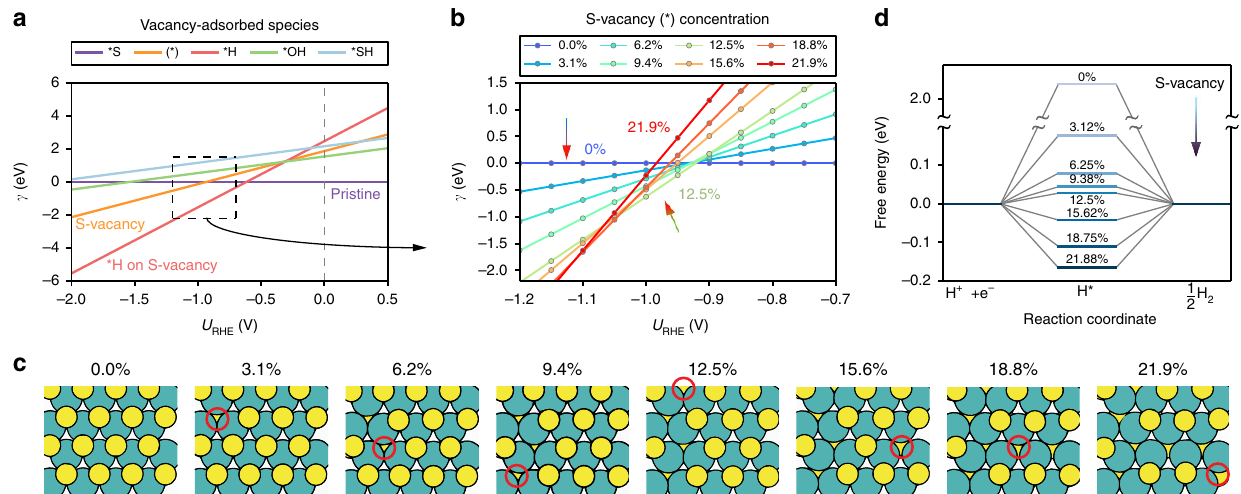
Figure 1 | Theoretical predictions. ( a ) Surface energy per unit cell for 2 H -MoS 2 as a function of applied potential for the basal plane of 2 H -MoS 2 with different adsorbate species at a fixed sulfur vacancy (3.1%). The surface energies of various species in the S-vacancy are shown. (*) Refers to a S-vacancy and the adsorbed species in the S-vacancy are denoted by *prefix. *S refers to sulfur adsorbed in the vacancy, that is, a pristine basal plane without S-vacancies. ( b ) Surface energy per unit cell for a range of S-vacancy concentrations, without any adsorbates. The concentration of S-vacancies varies from 0 to 21.9% within the narrow range of (cid:2) 1.0V to (cid:2) 1.1V. In all cases, the surface energies are taken relative to a pristine basal plane ( g ¼ 0eV). ( c ) When the S-vacancy sites are generated in succession, S-vacancies are most stable when formed next to an existing S-vacancy. ( d ) Free energy diagram for the HER on S-vacancy sites. The results represent hydrogen adsorption on the most stable site within the computational